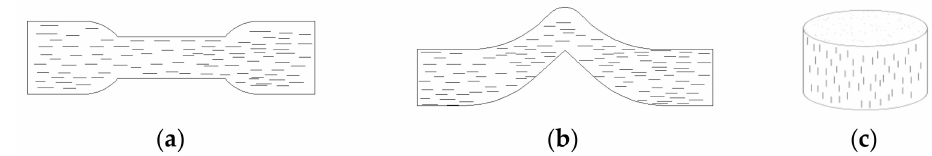
Figure 9. Samples for test. ( a ) Sample for tensile; ( b ) Sample for tear; ( c ) Sample for DIN wear.